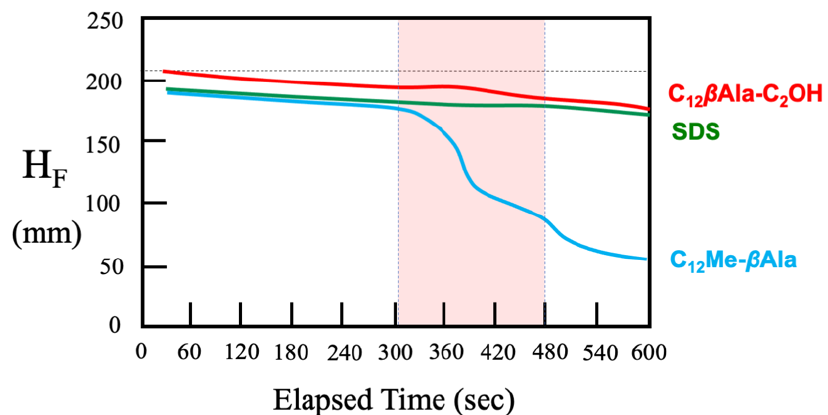
Figure 8. Evolution of foam heights (H F ) obtained using a dynamic foam analyzer for SDS (green), C 12 –EtOH– β Ala (red), and C 12 –Me– β Ala (blue). Foam of C 12 –Me– β Ala collapsed dramatically in the time domain from 300 to 480 s (indicated in red).